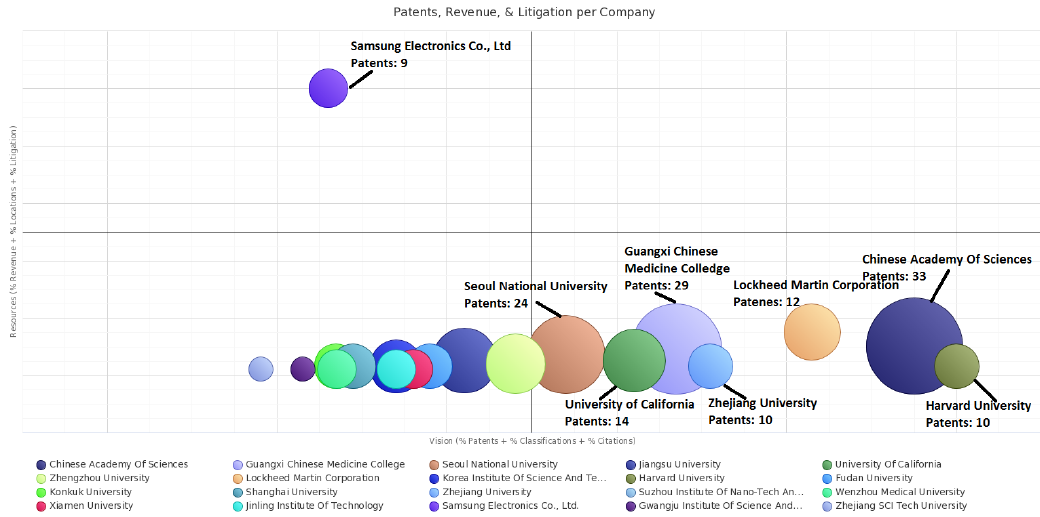
Figure 3. Competitive position of top assignees in graphene biomedical technology.